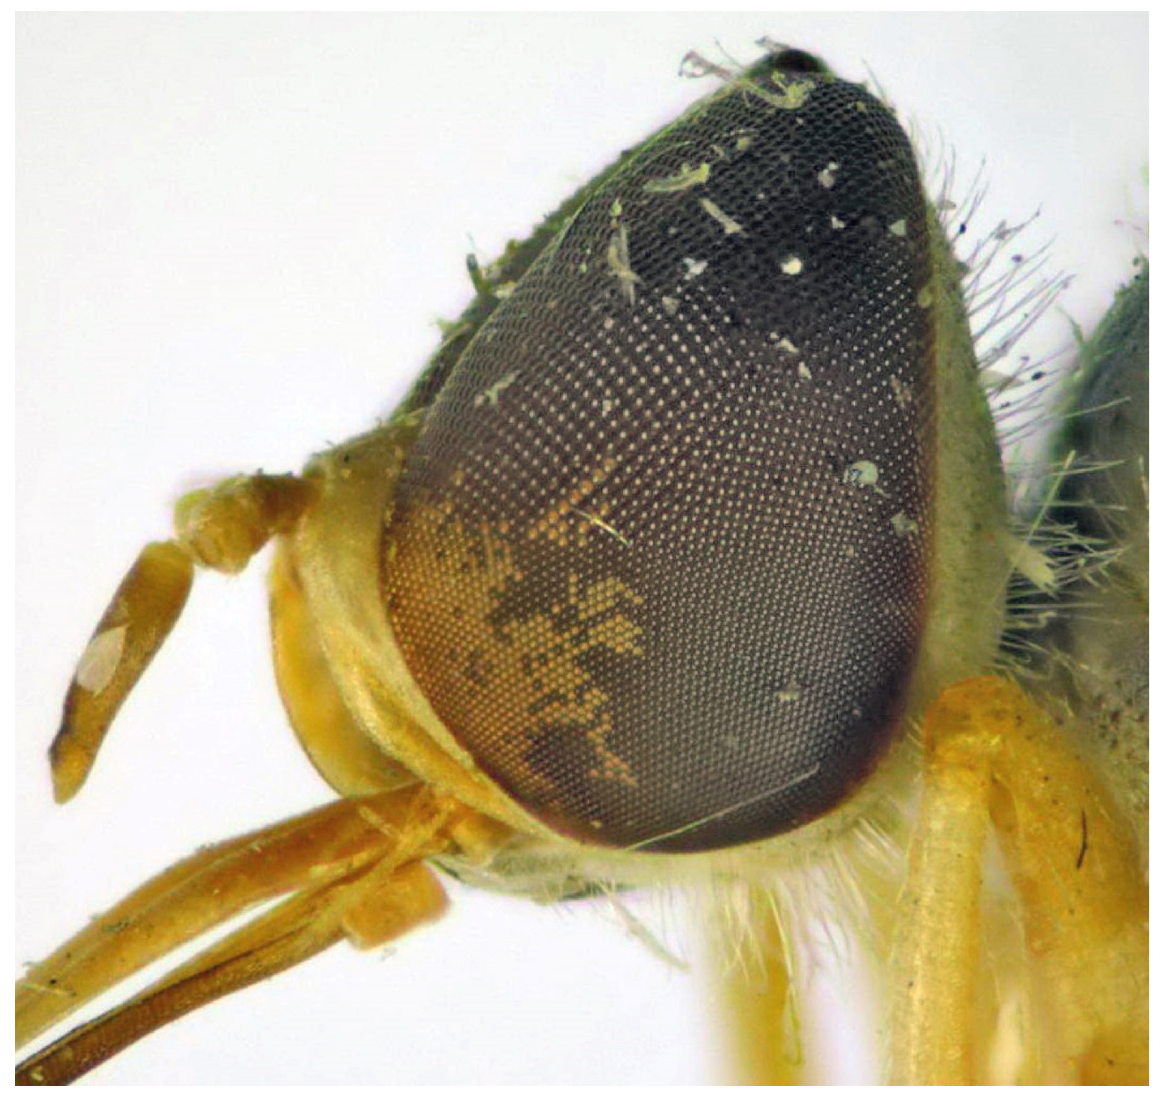
Fig. 3. Parageron orientalis Paramonov, 1929 stat. rev.,